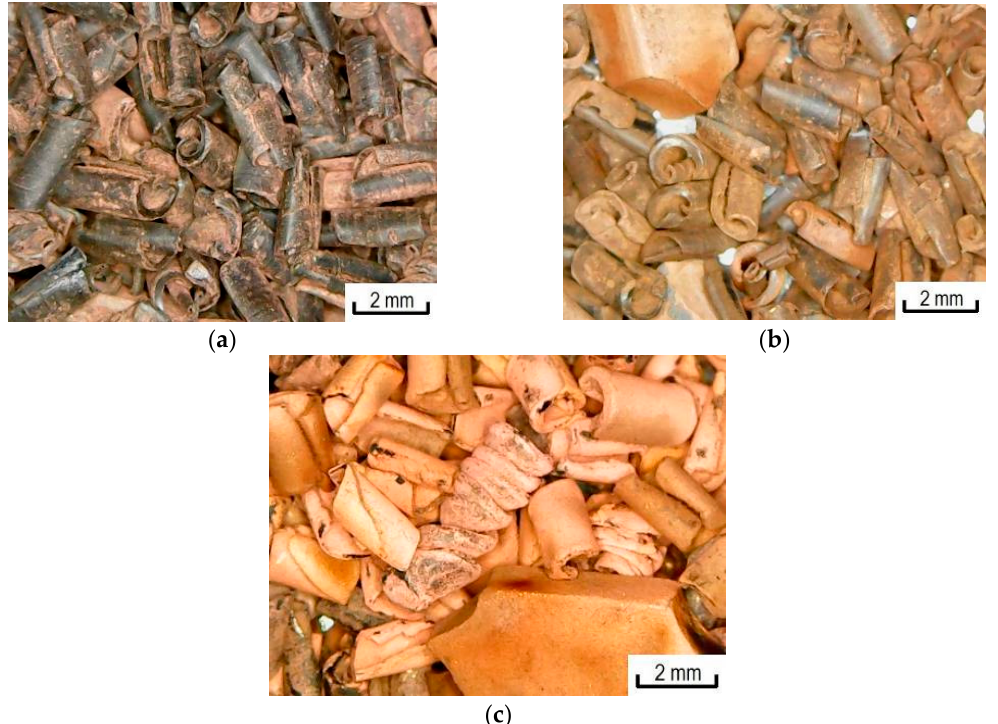
Figure 17. Photomicrographs of polypropylene waste. Copper content: ( a ) 5 wt.%; ( b ) 15 wt.%; ( c ) 20 wt.%.